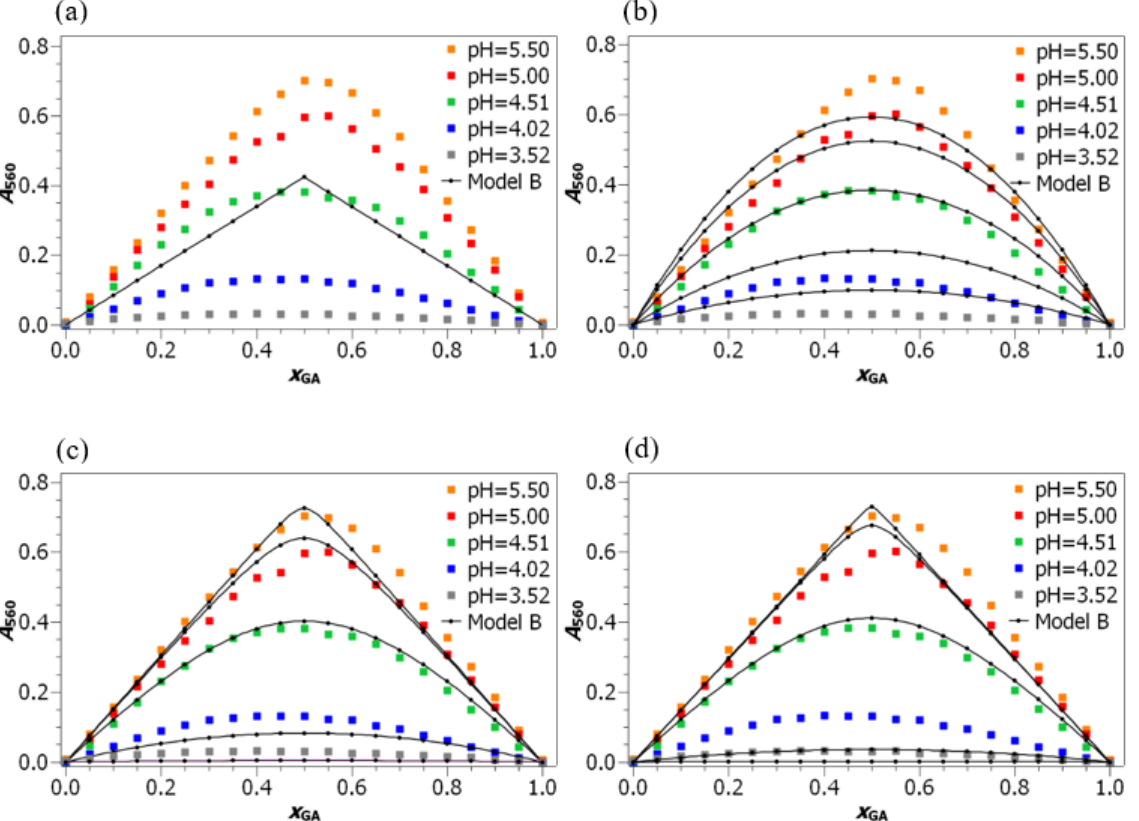
Figure 6. Different model functions B fitting with the results of experiments ( c = 5 · 10 − 4 mol · L − 1 ). We assumed that different types of gallic acid react with iron(II), which leads to the formation of the following coordination compounds: ( a ) [H 4 GAFe] 2+ , ( b ) [H 3 GAFe] + , ( c ) [HGAFe] − , ( d ) [GAFe] 2 −